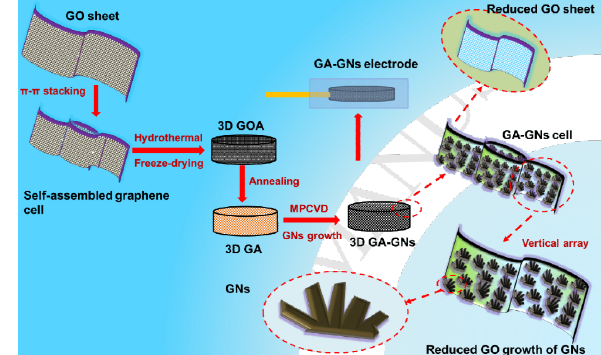
Figure 3: Schematic illustration of hierarchically